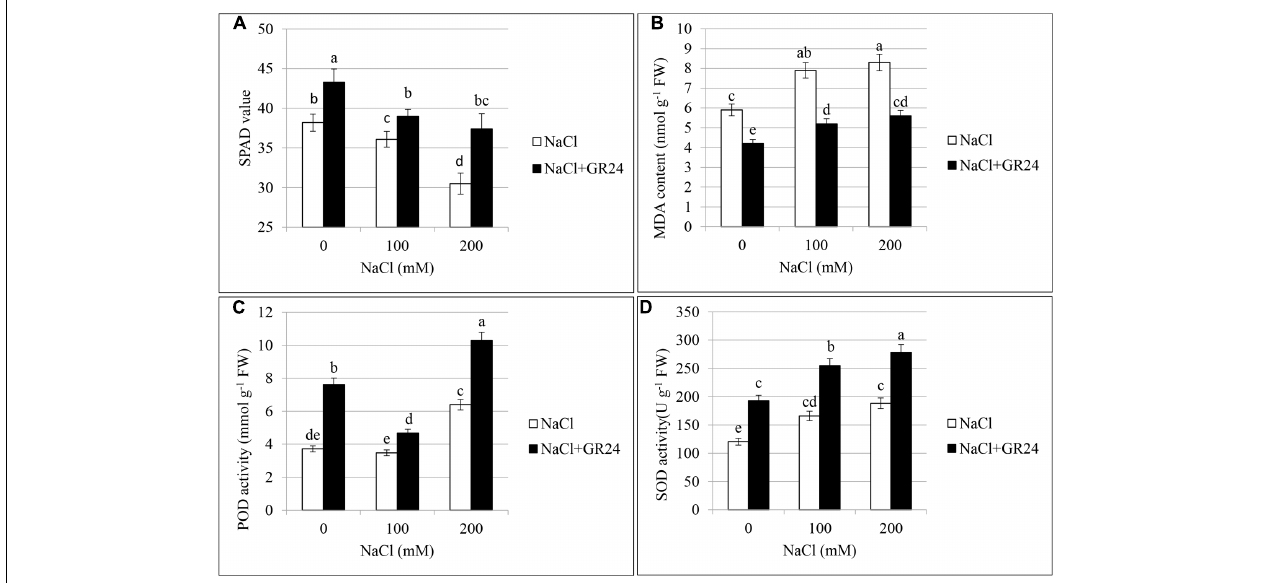
FIGURE 4 | Effects of GR24 and salinity stress on the soil and plant analyzer development (SPAD) value (chlorophyll content), lipid peroxidation, and activities of antioxidant enzymes of leaves in B. napus cv. ZS 11. SPAD value (A) , malondialdehyde (MDA) contents (B) , guaiacol peroxidase (POD) activity (C) , and superoxide dismutase (SOD) activity (D) at 7 days in the presence of GR24 (0.18 µ M) and salinity (0, 100mM and 200mM NaCl, respectively) in ZS 11 (n = 6). All experiments were repeated three times and the data represent means ± SE. Means followed by same small letters are not significantly different by the LSD test at P ≤ 0.05 level.